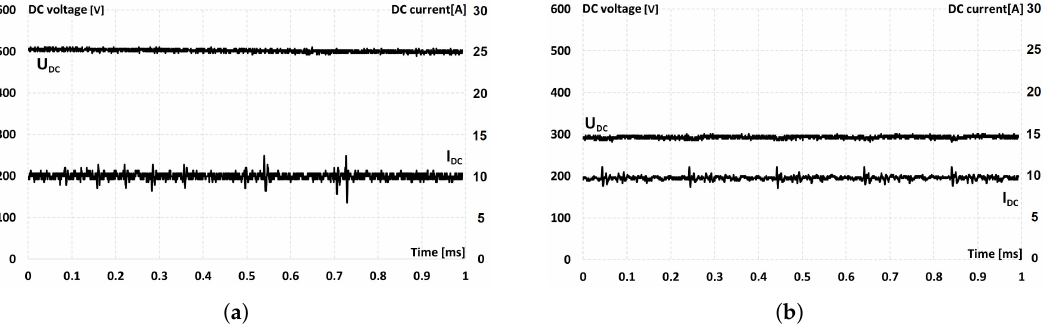
Figure 13. The DC output voltage and current of EV charger when current limiter in drive VFC is active at different value of rectifier load: ( a ) R = 50 Ω —the current limiter of the inverter is inactive, ( b ) R = 30 Ω —the current limiter of the inverter is active I limit = 8.0